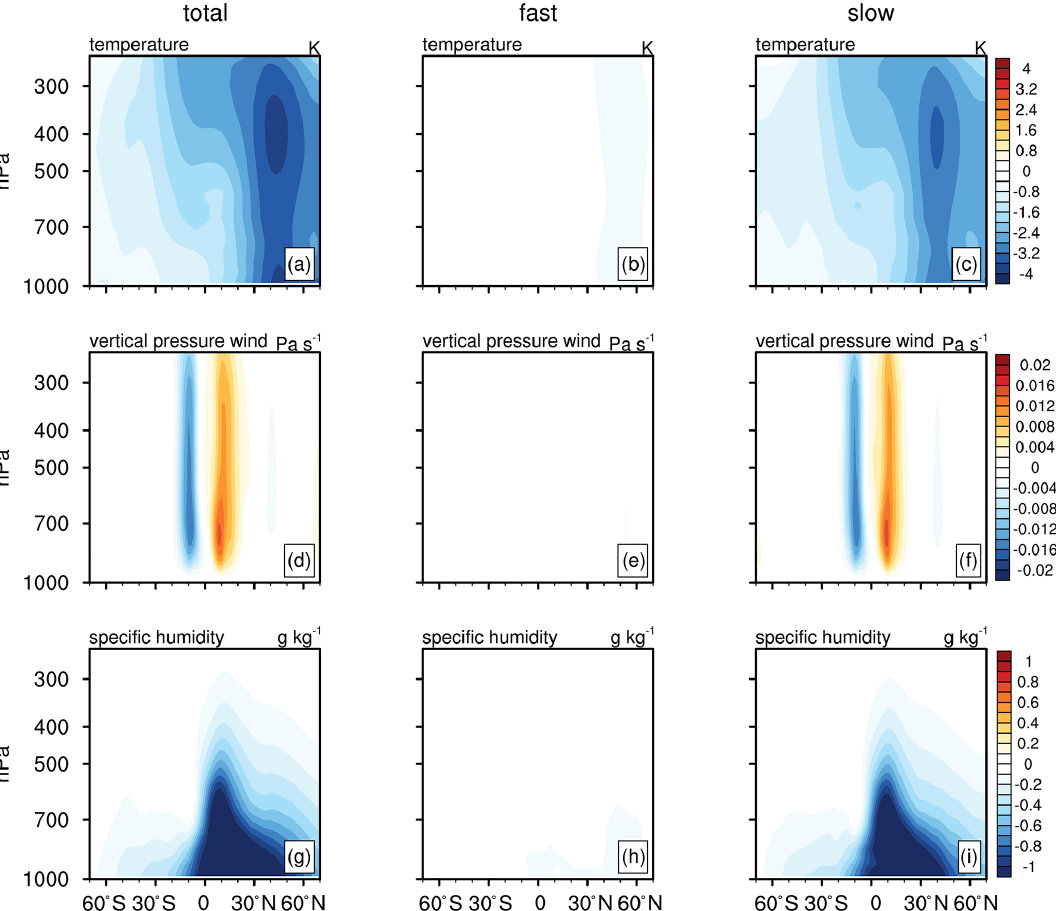
Figure 7. ECHAM6–HAM2 simulated multi-annual (a, d, g) total, (b, e, h) fast, and (c, f, i) slow responses of zonally averaged (a–c) temperature, (d–f) vertical pressure velocity, and (g–i) specific humidity in response to 5-fold increased SUL precursor emission. The blue colour indicates large-scale ascent, and the red colour indicates large-scale descent in (d–f)